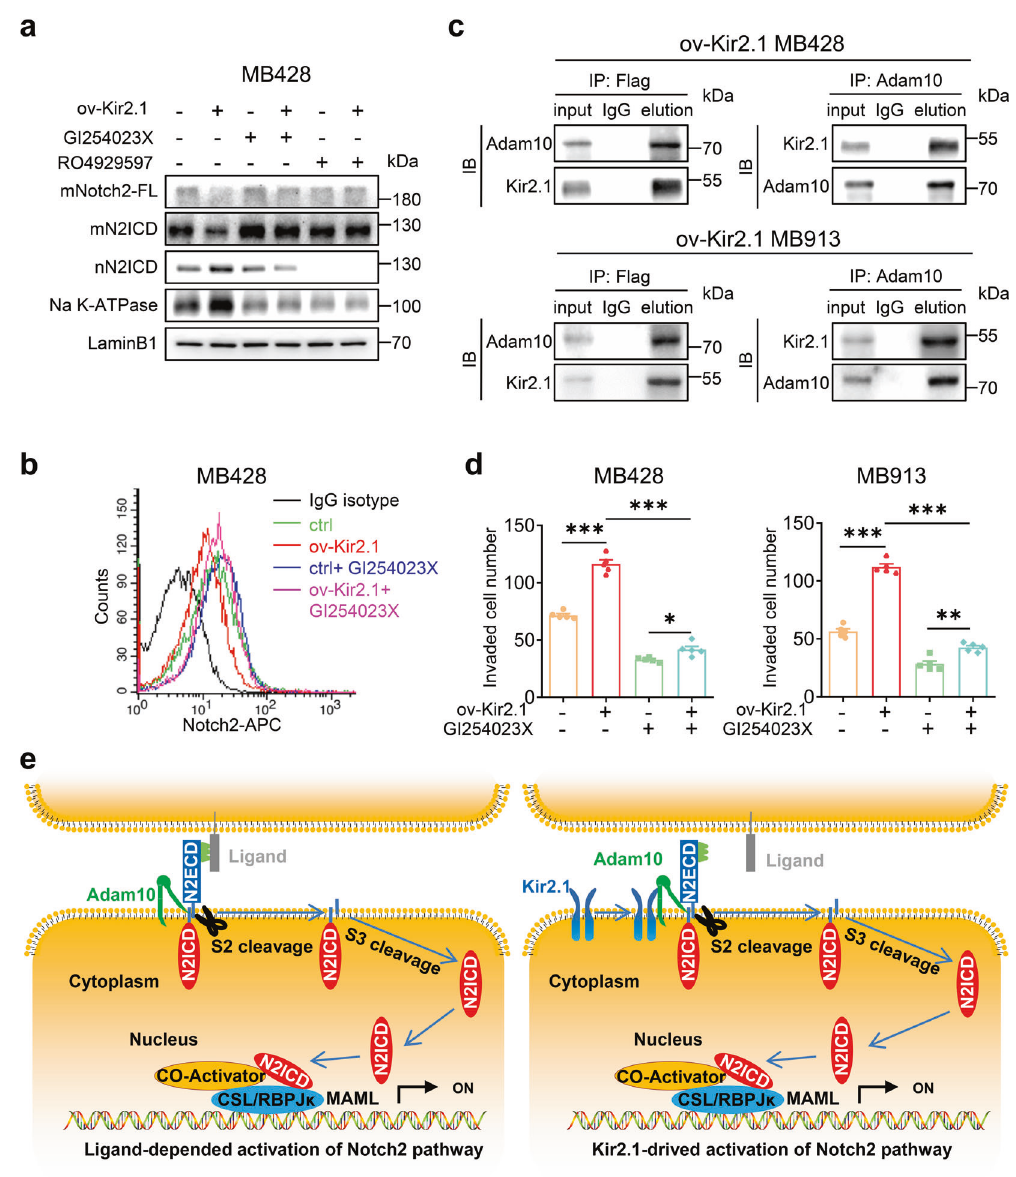
Fig. 5 Kir2.1 enhances S2 cleavage to activate Notch2 signaling. a Western blotting showing that overexpressing Kir2.1 markedly reduced the membrane full length Notch2 (mNotch2-FL) and the membrane intracellular domain of Notch (mN2ICD), whereas treatment with GI254023X (S2 inhibitor, 3 μ M) increased mNotch2-FL and mN2ICD in control cells and abolished the effect of Kir2.1-overexpressing in Kir2.1- overexpressing MB428 cells; treatment with S3 inhibitor (RO4929597) increased mN2ICD and abolished nN2ICD in both Kir2.1-overexpressing MB428 cells and control cells. b FACS showing that S2 cleavage inhibitor attenuated the ability of overexpressing Kir2.1 to reduce the extracellular domain of Notch2 in MB428 cells. c Co-IP showing Kir2.1 interaction with Adam10. Here, anti-Flag antibody was used to bind Flag-tagged Kir2.1 in Kir2.1-overexpressing cells. d Matrigel-transwell invasion assays showing that S2 cleavage inhibitor inhibited Kir2.1- promoted invasion of MB428 and MB913 cells. Data are shown as the mean ± S.D., n = 5, ns, not signi fi cant, * P < 0.05, ** P < 0.001, *** P < 0.0001, ANOVA test. e A model summarizing the novel Notch2 signaling pathway activated by Kir2.1. Left panel, S2 cleavage after ligand stimulation in MB cells; Right panel, Kir2.1 triggering S2 cleavage independent of ligand binding in MB cells. N2ECD: Notch2 extracellular domain compared to control cells, while GI254023X treatment slightly 5a and Supplementary Fig. 12a, overexpressing Kir2.1 in MB cells increased cell surface Notch2-FL in control cells and blocked the markedly reduced the full-length membrane Notch2 (mNotch2-FL) effect of Kir2.1 overexpression on decreasing cell surface Notch2-FL (detected by an antibody against the extracellular domain of Notch2) in Kir2.1-overexpressing cells (Fig. 5b and Supplementary Fig. 12b). and mN2ICD (N2ICD with a transmembrane domain), but increased Co-IP showed that Kir2.1 pulled down Adam10 and vice versa in ov- nuclear N2ICD (nN2ICD), while treatment with GI254023X, a speci fi c Kir2.1 MB428 and MB913 cells that expressed Flag-Kir2.1 (Fig. 5c), and inhibitor of Adam10, abolished the effect of Kir2.1-overexpression, this interaction was veri fi ed by Co-IP using anti-Adam10 antibody in resulting in increased mNotch2-FL and mN2ICD but decreased wild type MB428 cells (Supplementary Fig. 13). In addition, treatment nN2ICD. Flow cytometer analysis also showed that overexpressing with the S2 inhibitor GI254023X markedly decreased the invasive Kir2.1 in MB cells signi fi cantly decreased cell surface Notch2-FL as